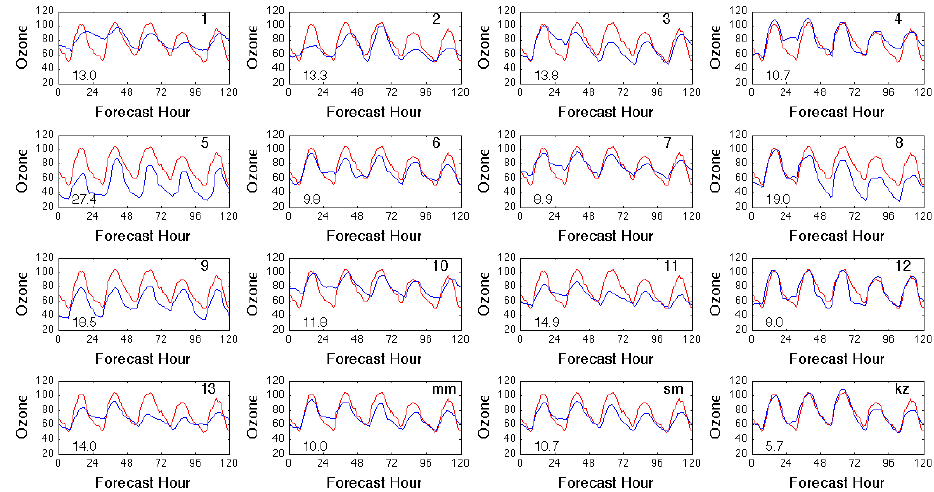
Fig. 3. The skill of the weekly provision of the kz model is validated, with respect to the RMSE, against the observations over the PREDICT period (from t 0 to t 0 + 7 days). Numbers 1–13 correspond to the id of the deterministic models, mm is the median model and sm is the spectral median model. Figure 4: